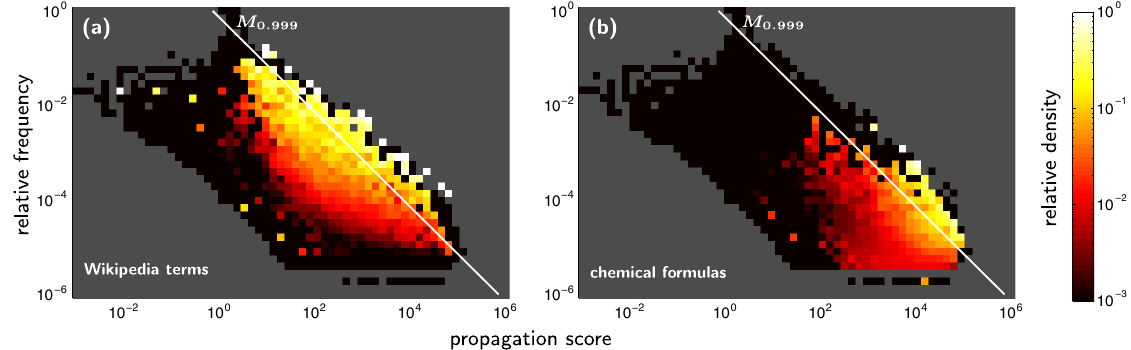
FIG. 4. Panel (a) shows that phrases with a high meme score (i.e., around the 99.9% quantile M 0 Wikipedia articles on physics, while other phrases tend not to. Panel (b) shows that phrases of relatively low frequency but high meme score have the highest density of terms containing chemical formulas (e.g., MgB 2 ). The data points of the two plots are the same as in Fig. 2(a), except for the colors showing the relative density of the specific type of terms. Note that the colors are log scaled: white stands for 100% terms of the given type, yellow for ≈ 30% , orange for ≈ 10% , light red for ≈ 2% , dark red for < 1% , and black for < 0 . 1%